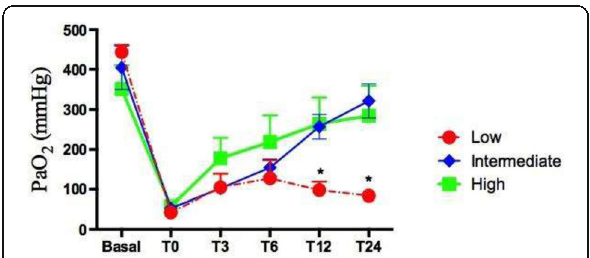
Fig. 1 (abstract 0030). Evolution of PaO2 levels in the 3 study groups. p<0.05 vs Intermediate and High